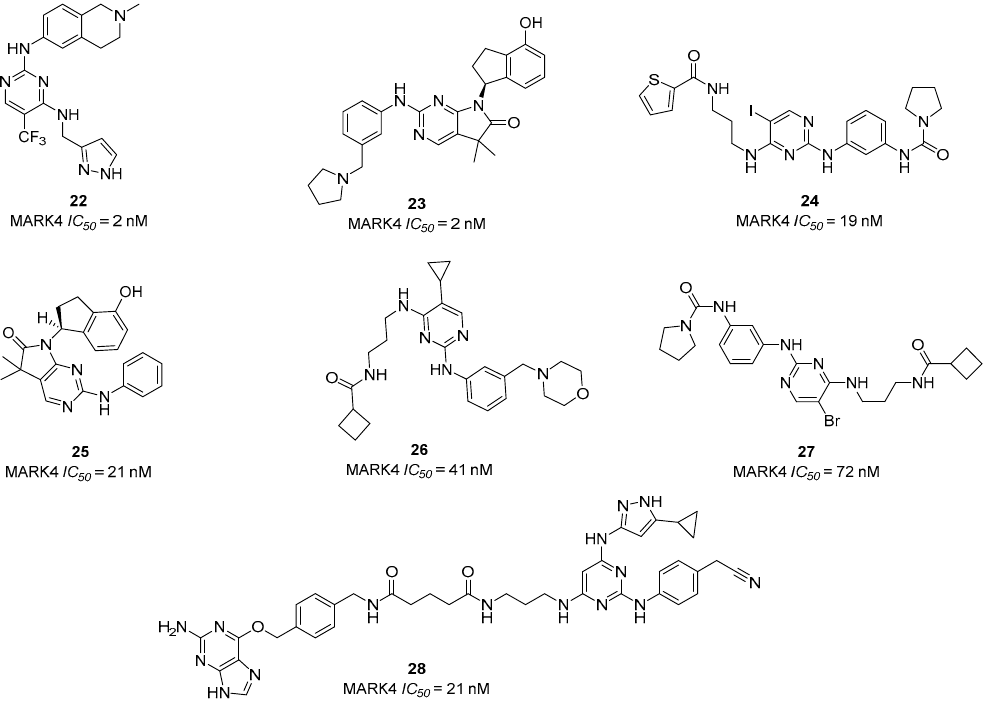
Figure 7. The most potent MARK4 inhibitors (IC 50 < 100 nM) 22 [62] , 23, 24, 26 [63] , 25 [64] , 27 [65], 28 [66]